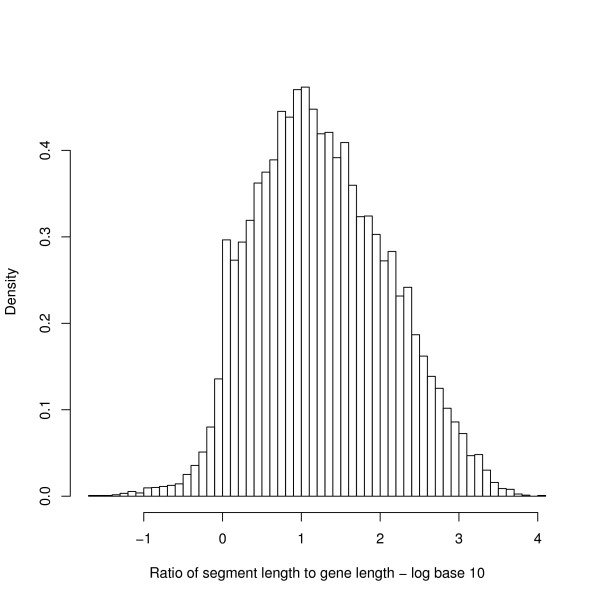
Histogram of ratio of length of containing segment to gene length. The median ratio is 16 and there is an apparent boundary to the distribution at a ratio around 1. The interquartile range of the ratio is [4.4, 72]. The x-axis is plotted using logs to base 10. The number of genes in the plot is 23878. The segment bias operates on a larger scale than the transcription bias.